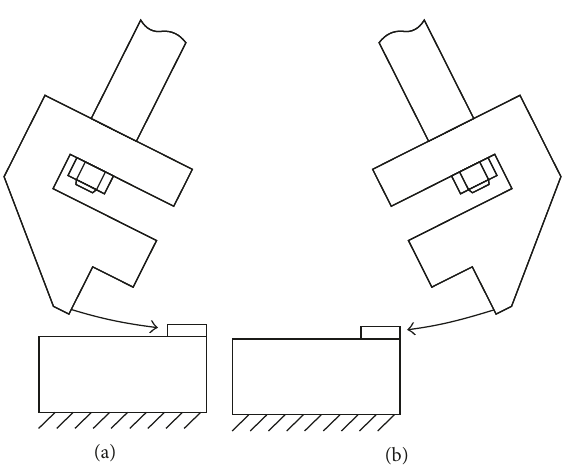
Figure 2: Diagram of research into impact loading. (a) Normative [4]; (b) nonnormative.